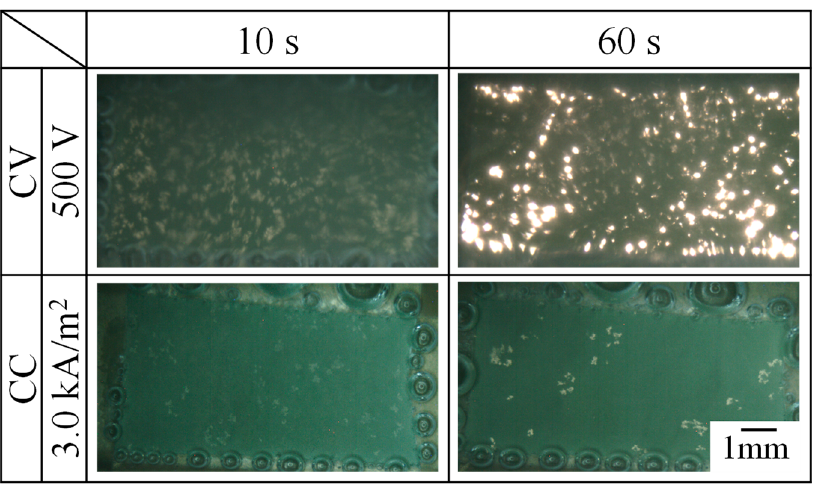
Figure 7. Behavior of micro-arcs in the front view during the PEO process by CV operation and by CC operation.